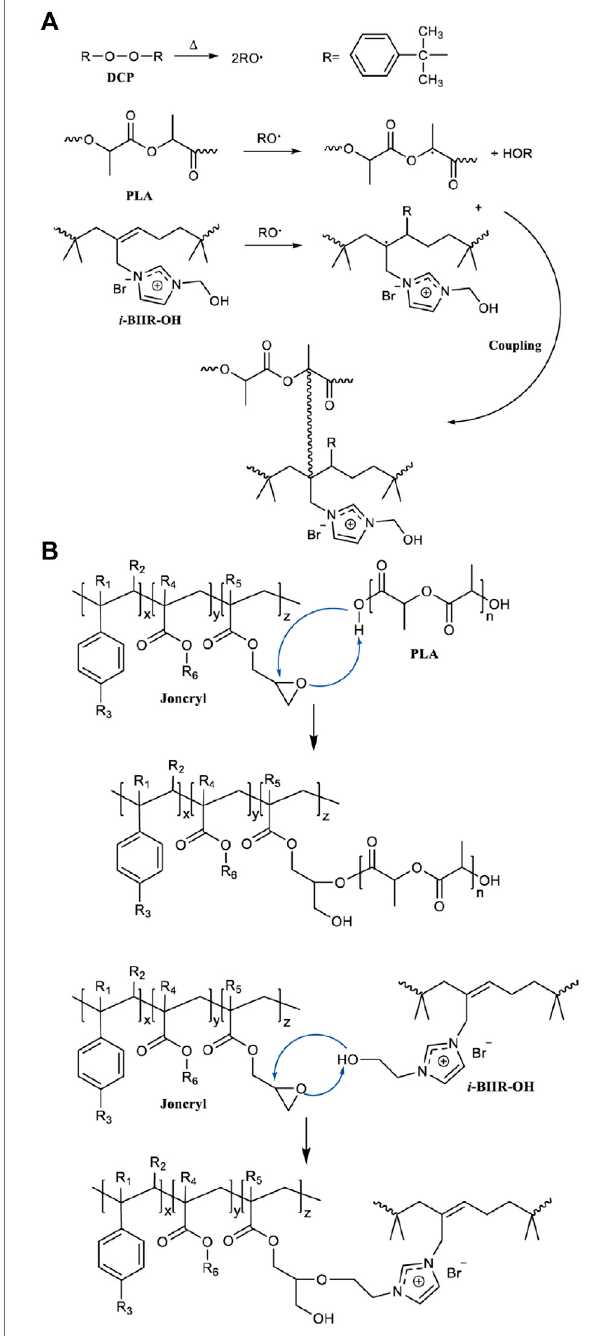
SCHEME1| Schematicdiagramofthemainreactionduringthereactive blending: (A) the reaction caused by the addition of DCP, (B) the reaction caused by the addition of